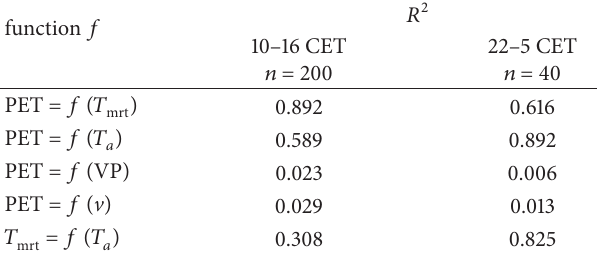
Figure 21: 1h mean values of the difference between mean radiant Figure 23: 1h mean values of the sums of short-wave radiant and air temperature 𝑇 𝑎 , related to the 1h peak ) and long-wave radiant flux densities ( 𝐿 ∗ temperature 𝑇 flux densities ( 𝐾 ∗ mrt abs ∘ C) and − 𝑇 (𝑇 − 𝑇 ) value of ( 𝑇 from the three-dimensional environment absorbed by the human- 𝑎 ) at the shaded ( 𝑎 max = 31.2 mrt mrt ∘ C) SSW-facing sidewalk of a WNW- − 𝑇 ) sunny ( (𝑇 biometeorological reference person, related to 1h mean values of 𝑎 max = 39.9 mrt + 𝐿 ∗ ), at the shaded (by tree canopies) and sunny SSW- ESE street canyon, “Vauban” quarter in Freiburg during typical ( 𝐾 ∗ abs abs facing sidewalk of a WNW-ESE street canyon, “Vauban” quarter in Central European summer day. Freiburg during typical Central European summer day. Table 4: Coefficient of determination 𝑅 2 of linear regres- sion functions 𝑓 between 1h mean values of different human- biometeorological variables, basis: experimental investigations on typical Central European summer days in various urban quarters of Freiburg from 2007–2010 ( 𝑛 : number of